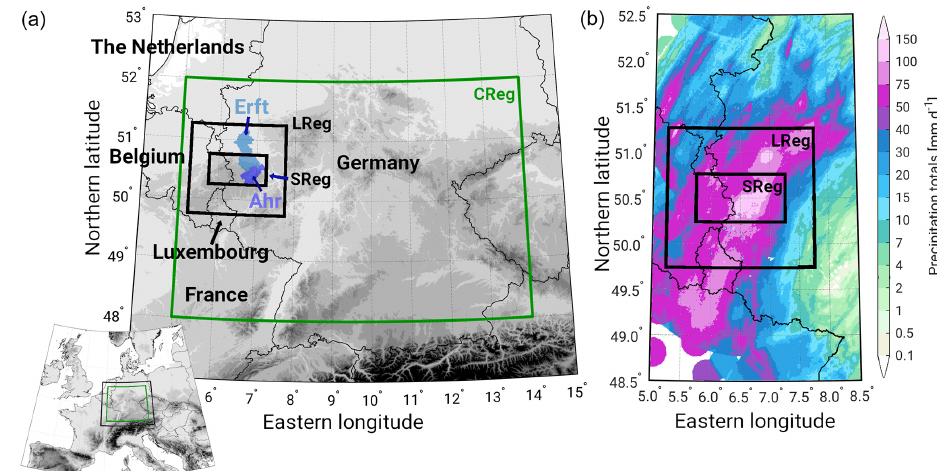
Figure 1. (a) Overview map of central and western Europe (bottom left) with a zoom-in on the region of interest and (b) 24h precipitation totals of 14 July 2021 based on RADOLAN (cf. Part 1). Two regions (LReg, SReg; black rectangles) covering the main precipitation area and the affected river catchments of the Ahr (dark blue) and the Erft (light blue) are defined to derive specific event characteristics (e.g., spatial means). Analyses in a statistical and climatological context are performed over the greater central Germany region (CReg, green box). Topographic data (gray) were provided by NOAA National Geophysical Data Center (Amante and Eakins,